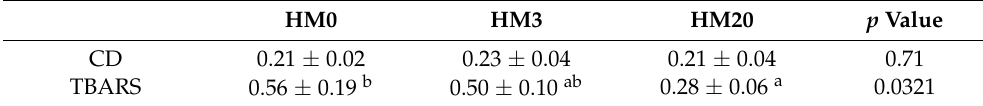
Table 8. Conjugated dienes (mmol hydroperoxides/100 g freeze-dried prawn muscle; CD) and thiobarbituric acid reactive substances (malondialdehyde equivalents on 100 g freeze-dried prawn muscle; TBARS) measured in the muscle of giant freshwater prawn fed the experimental diets over the 60-day